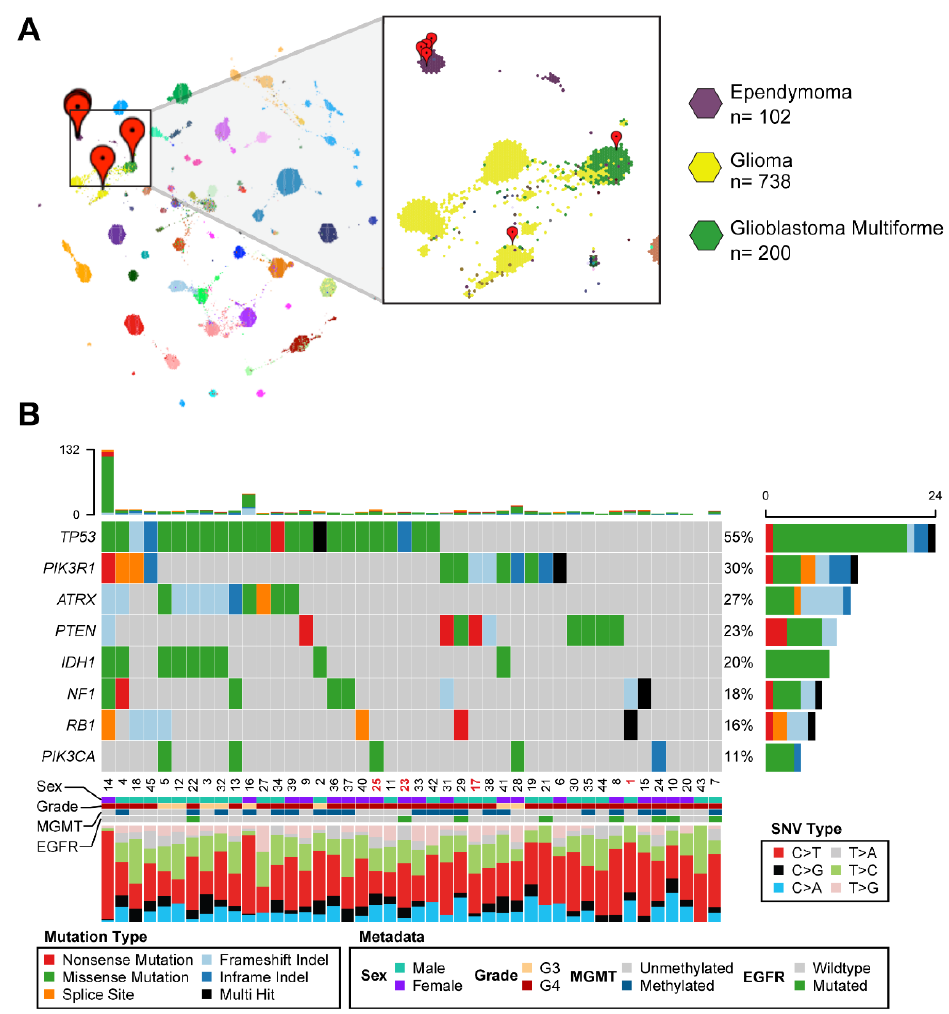
Figure 2. Patient 1 index tumor was extensively characterized using RNA and DNA sequencing. ( A ) TumorMap of Patient 1 relative to the pan-cancer polyA compendium of solid tumors. Spearman correlation was used to identify the top six most correlated samples, which are highlighted with red markers and correlated to tumor type of either ependymoma (purple, 4 tumors), DIPG astrocytoma (yellow, 1 tumor), and glioblastoma (green, 1 tumor). ( B ) Oncoplot depicting somatic mutations present in the UAMS GBM compendium. Mutations were detected using targeted exome sequencing. Barplot at the top shows total number of mutations per sample. Barplot at the right shows number of affected samples. The stacked barplot at the bottom identifies the proportion of each type of single nucleotide variant present. Sex, tumor grade, MGMT methylation status, and EGFR mutation status (assayed via PCR) are also shown below. All 8 genes displayed were significantly mutated in these samples ( p < 0.1). Table 1. List of spearman correlation values of the top six highest correlated tumors to that of Patient